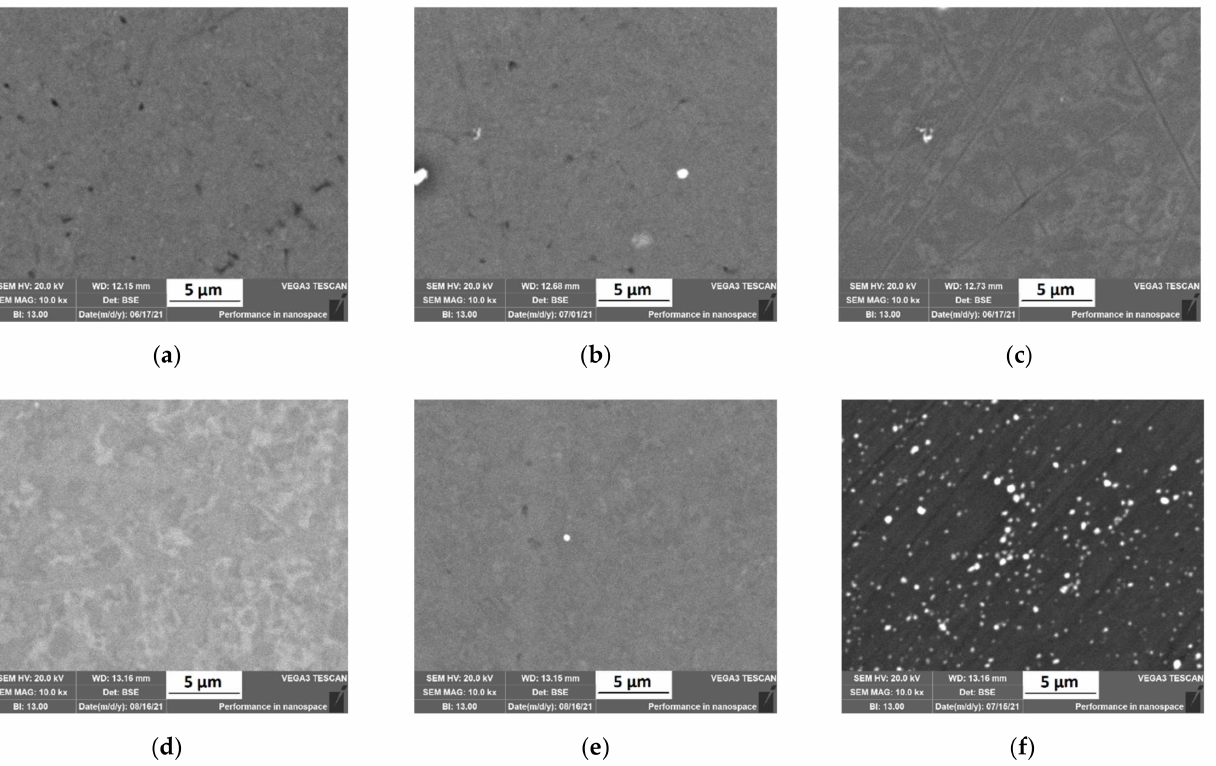
Figure 8. Number and size of dispersoids in alloys. Al 0.3 Mg 1 Si: ( a ) steel chill mold; ( b ) copper chill mold; ( c ) copper chill mold of round section. Al 0.3 Mg 1 Si 0.3 Sc 0.15 Zr: ( d ) steel chill mold; ( e ) copper chill mold; ( f ) copper chill mold of round